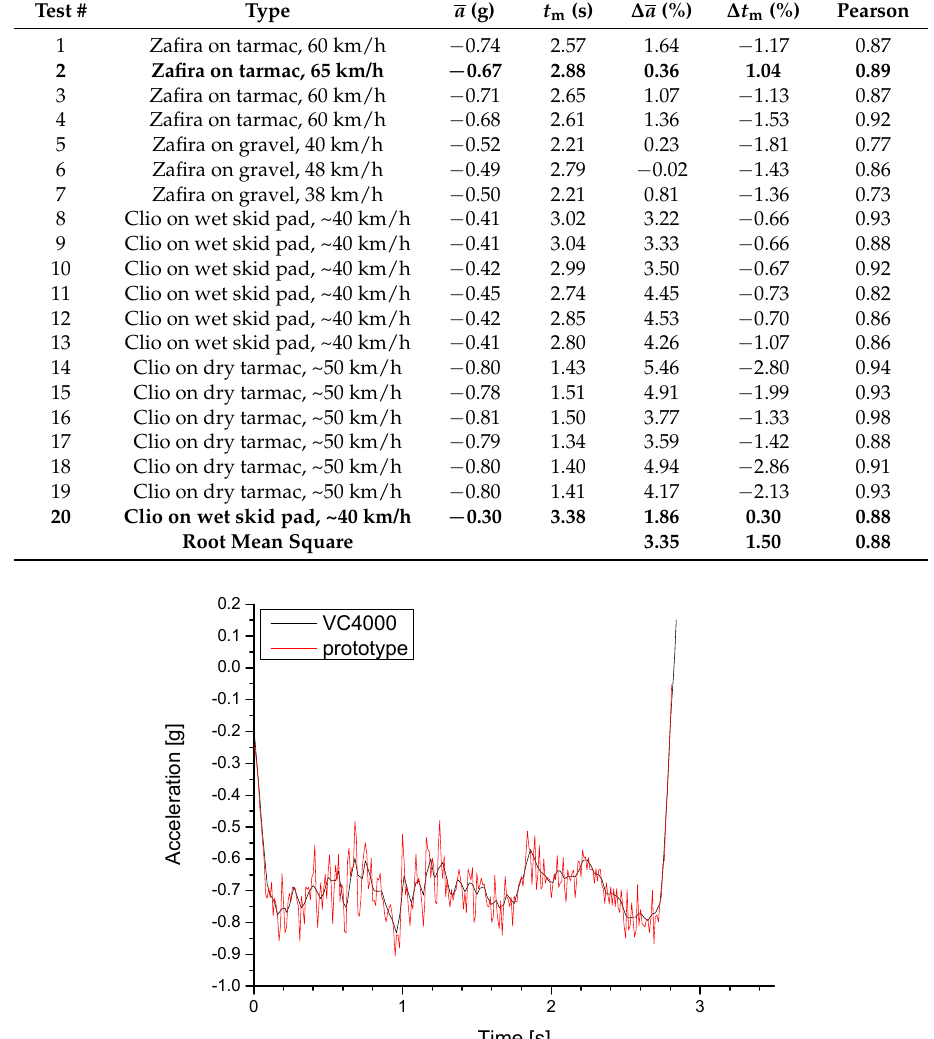
Figure 9. Measured acceleration during braking (passenger car on dry tarmac, 65 km/h, test #2).